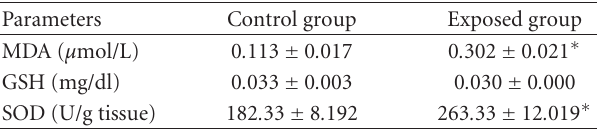
Table 1: The levels of MDA ( μ mol/L), GSH (mg/dl) and SOD (U/g tissue) in the brain of control newborn rats and those exposed to 50Hz 0.5 mT MF for 30 days 24 h/day. Each value was expressed as mean of 10 rats ± standard